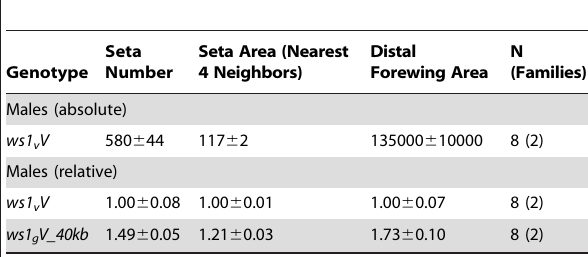
Table 2. Cell number and size effects of ws1 , as estimated by seta number and area.